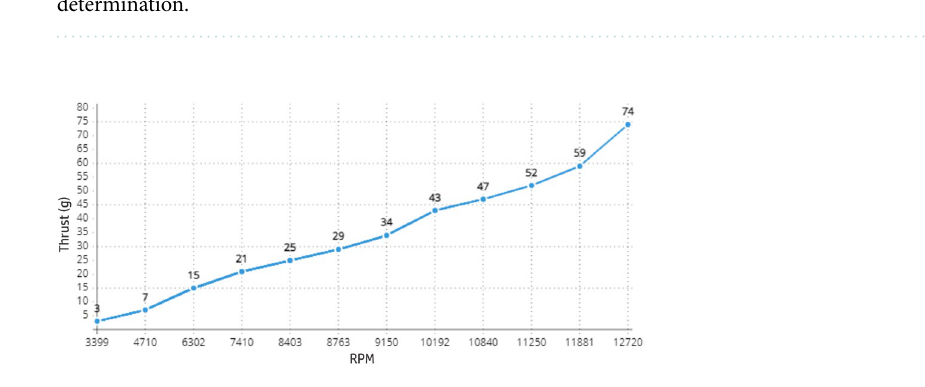
Figure 25. Graphic of the static thrust in 12 RPM rates. A maximum of 74 g for a rotation per minute rate of 12720 (RPM) is achieved.